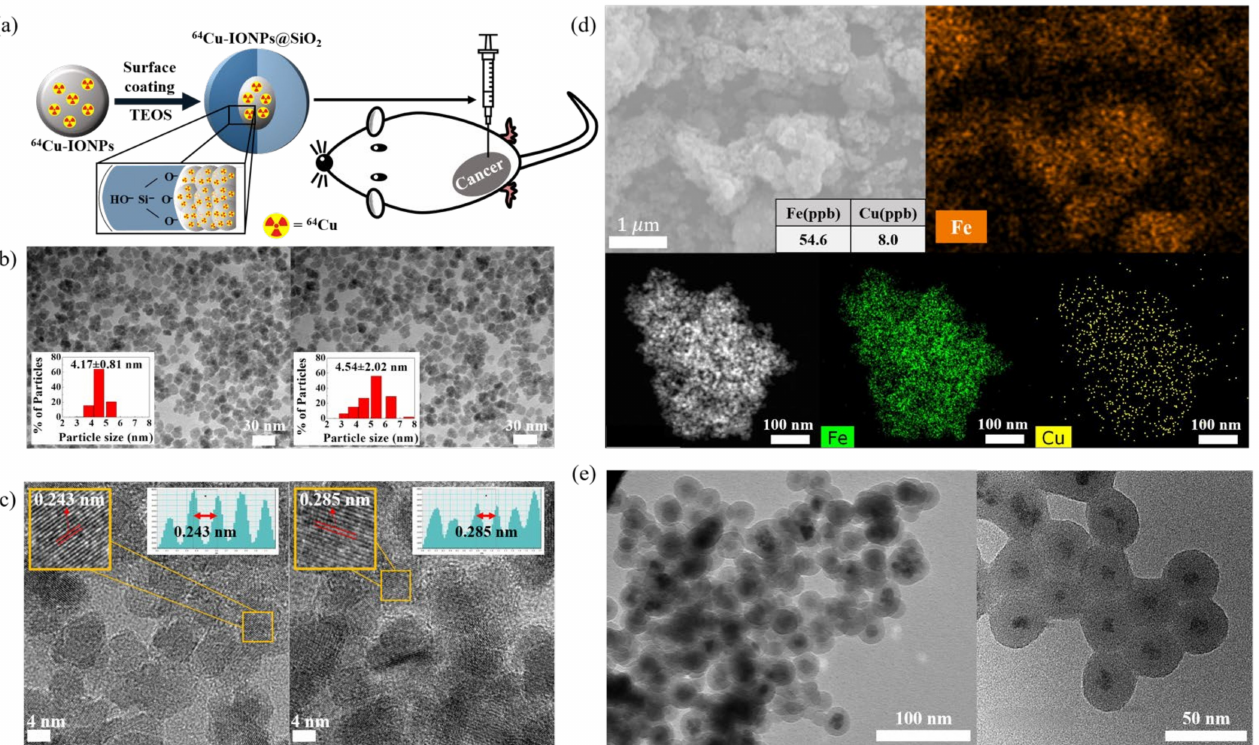
Figure 1. ( a ) Schematic cartoon for the experimental process for synthesizing the NPs, coating with TEOS, injecting the NPs into BALB/c mice, and PET and MRI imaging. ( b ) TEM images of IO and 64 Cu-IO NPs. The inset displays the size distribution acquired by measuring at least 200 NPs from the corresponding TEM image of each sample. ( c ) The lattice constants of IO and 64 Cu-IO NPs obtained from TEM images for both samples. ( d ) SEM images of IO NPs (upper panel) and TEM images of chelator-free 64 Cu-IO NPs (lower panel) with elemental mapping analysis confirming the presence